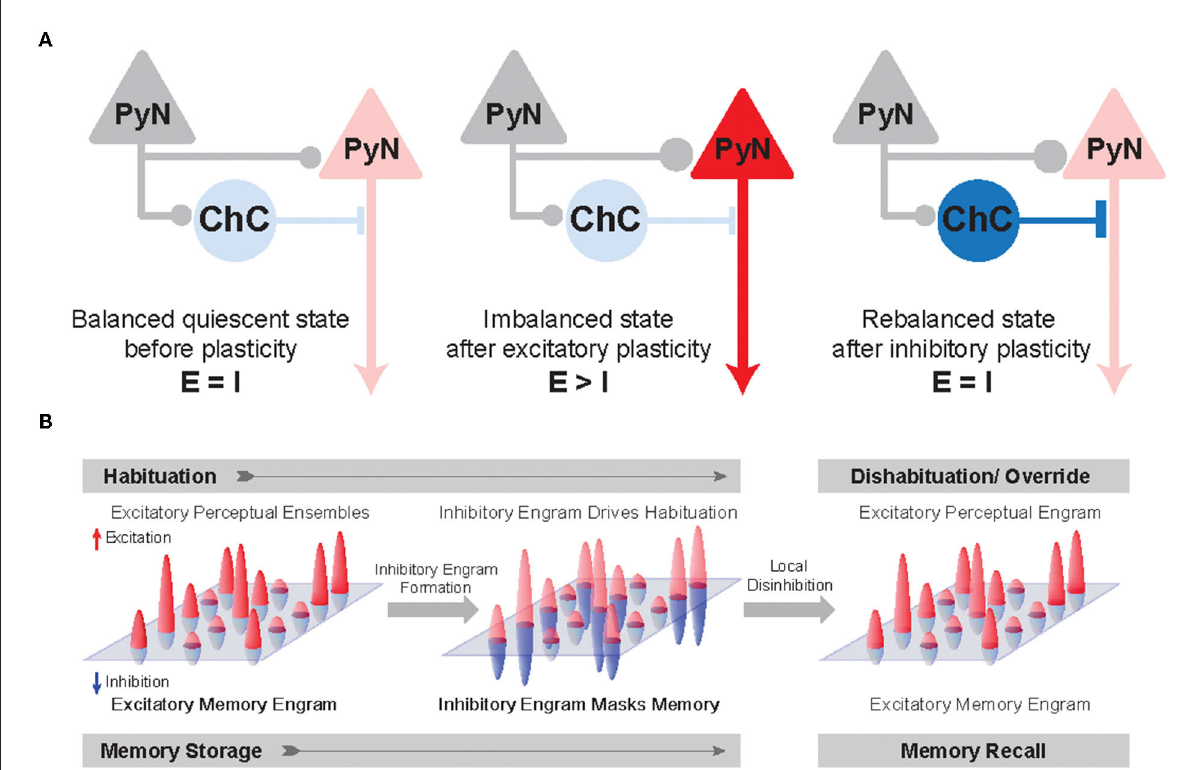
FIGURE4 Inhibitory synapse plasticity for E/I rebalancing and inhibitory engram formation in perception and memory. (A) Schematic circuit diagram showing pre-synaptic PyNs (gray), post-synaptic PyNs (red), and ChCs (blue). The post-synaptic PyN receives balanced excitatory and inhibitory inputs (Balanced quiescent state). The effect of excitatory plasticity between pre- and post-synaptic PyNs initially leads to E/I imbalance (Imbalanced state). Inhibitory plasticity in axo-axonic synapses between ChCs and PyNs can subsequently restore E/I balance